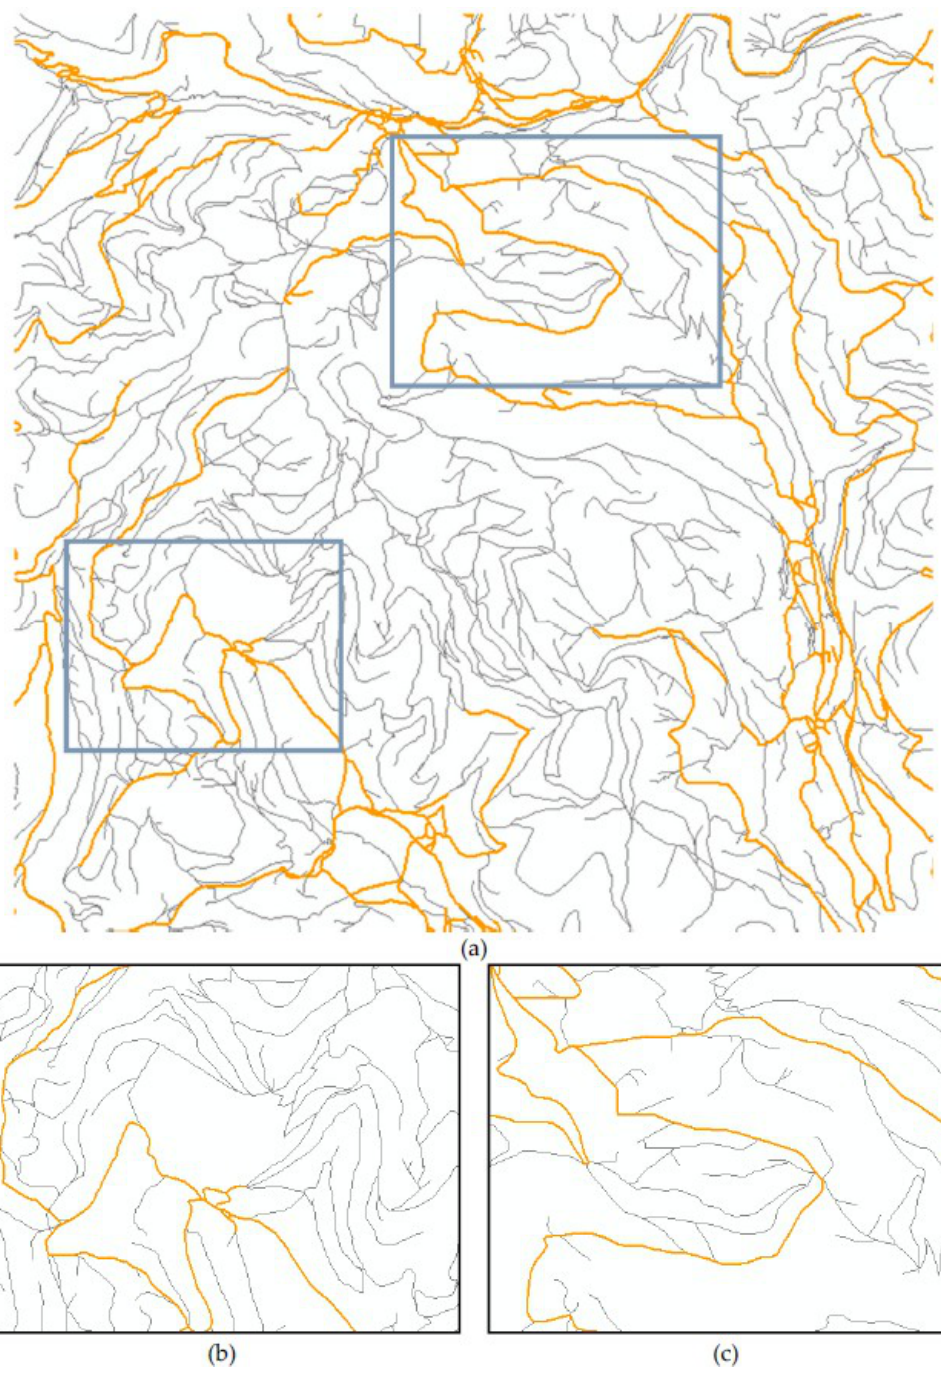
Figure 9. An example of the conflated road network in a rural area: ( a ) a randomly selected area of 7 ˆ 7 km 2 in Garmisch, Germany; ( b ) partial enlarged view of (a); ( c ) partial enlarged view of (a). Orange: the initial road network of NAVTEQ; grey: the conflated roads from